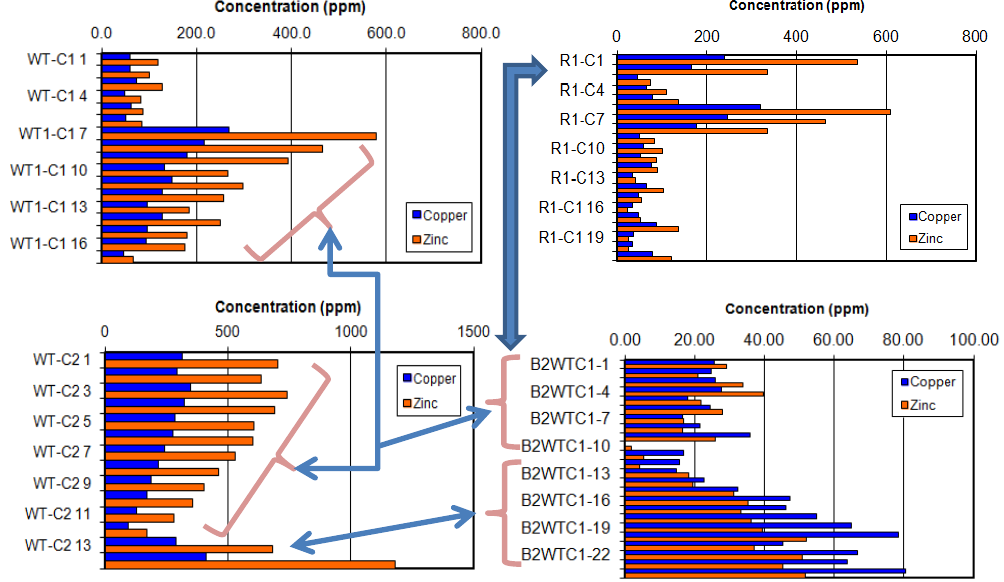
Fig. 11. Variations in Cu and Zn concentrations with depth in wetland Cores WT-C1 (a) , WT-C2 (b) , R1C1 (c) , and B2WTC1 (d)